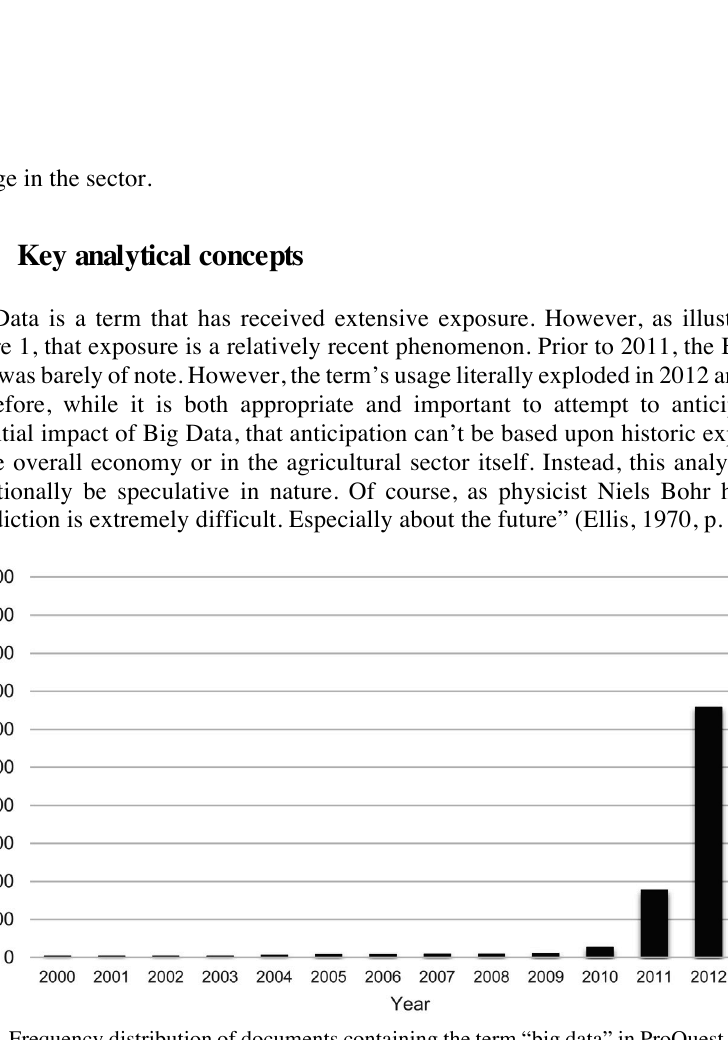
Fig. 1. Frequency distribution of documents containing the term “big data” in ProQuest Research Library (Gandomi and Haider,